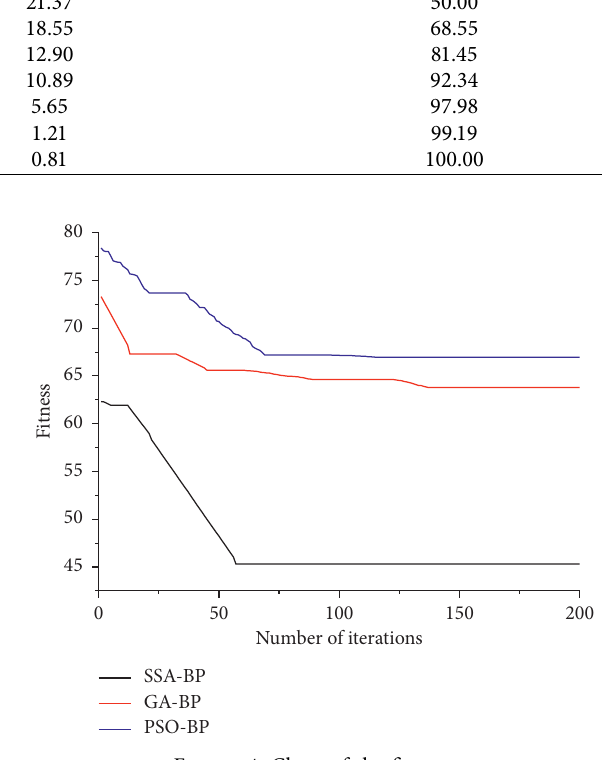
Figure 4: Chart of the